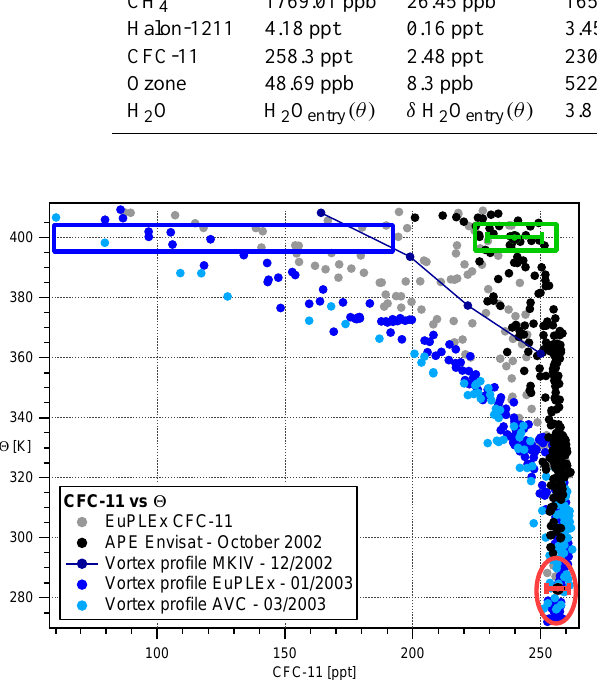
Fig. 3. Vertical profiles of HAGAR CFC-11 (ppt) plotted vs the potential temperature θ (K). Blue symbols indicate an early winter (dark blue line with dots), a mid winter (EuPLEx, dark blue circles) and a late winter (AVC, light blue circles) profile measured in the vortex region. A mid-latitude profile (October 2002) is displayed as black circles. Gray circles show all other data obtained in winter 2003. The data determining the boundary conditions are highlighted by